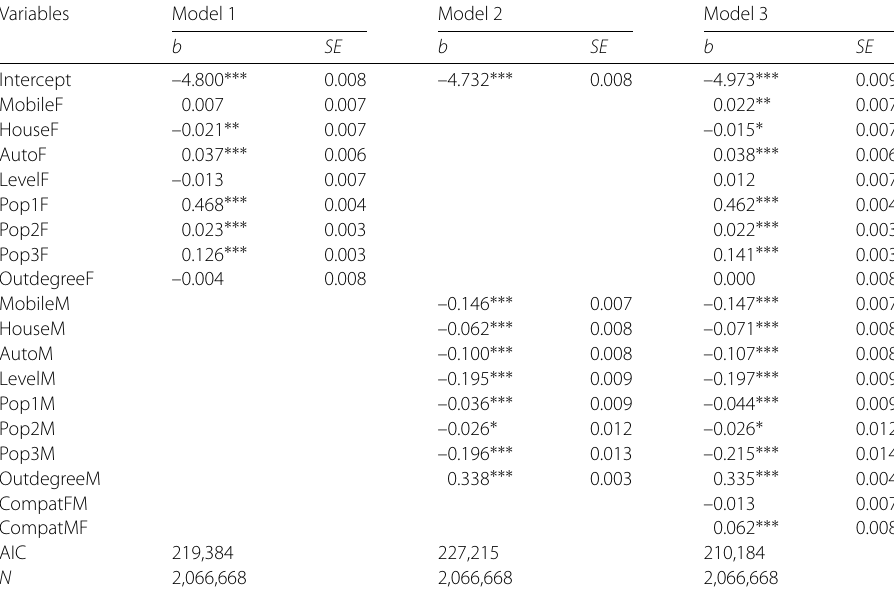
Table 3 Logistic regression results for male users sending messages to female users